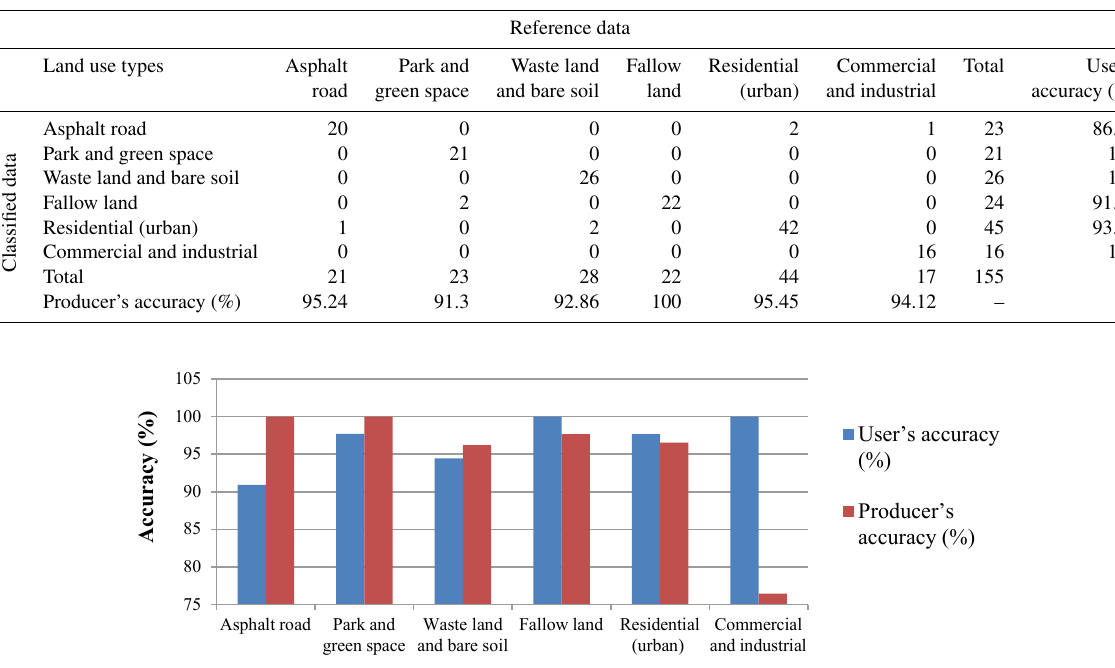
Solid Earth, 7, 1551–1564,